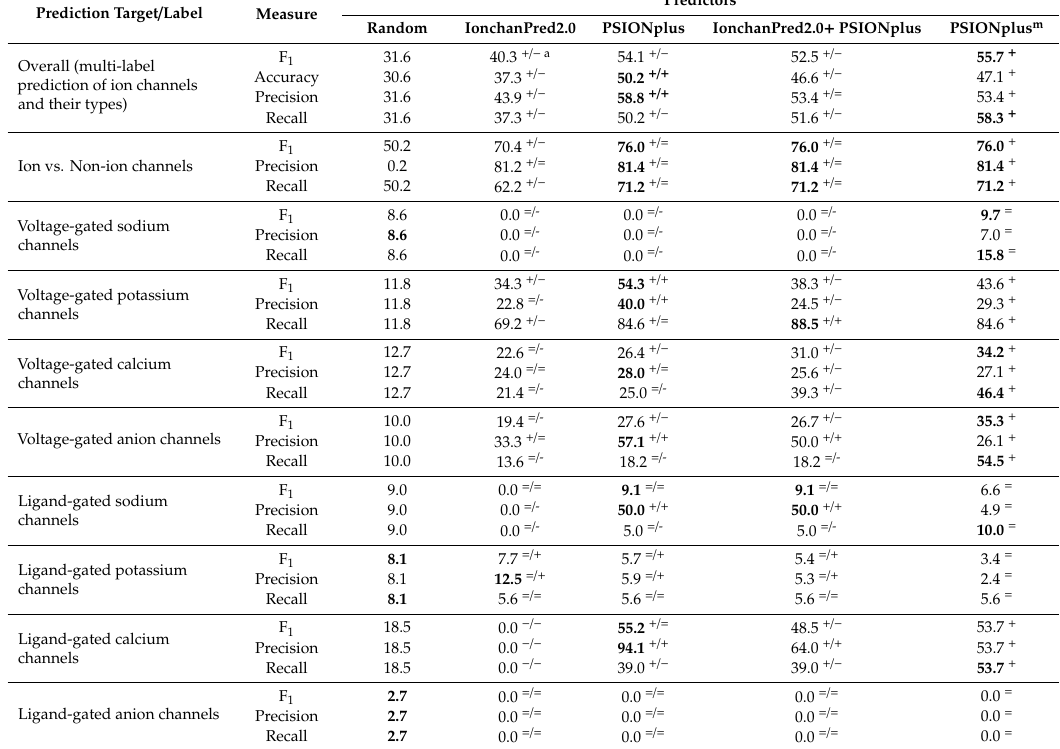
Table 3. Evaluation of the sequential prediction of ion channels and their subtypes on the benchmark dataset. The random predictor is implemented by shu ffl ing the actual labels; we report the average based on 1000 repetitions. The IonchannelPred2.0 + PSIONplus is a multi-label prediction that combines outputs generated by these two methods. The best values for each row (a given quality index and outcome) are shown in bold